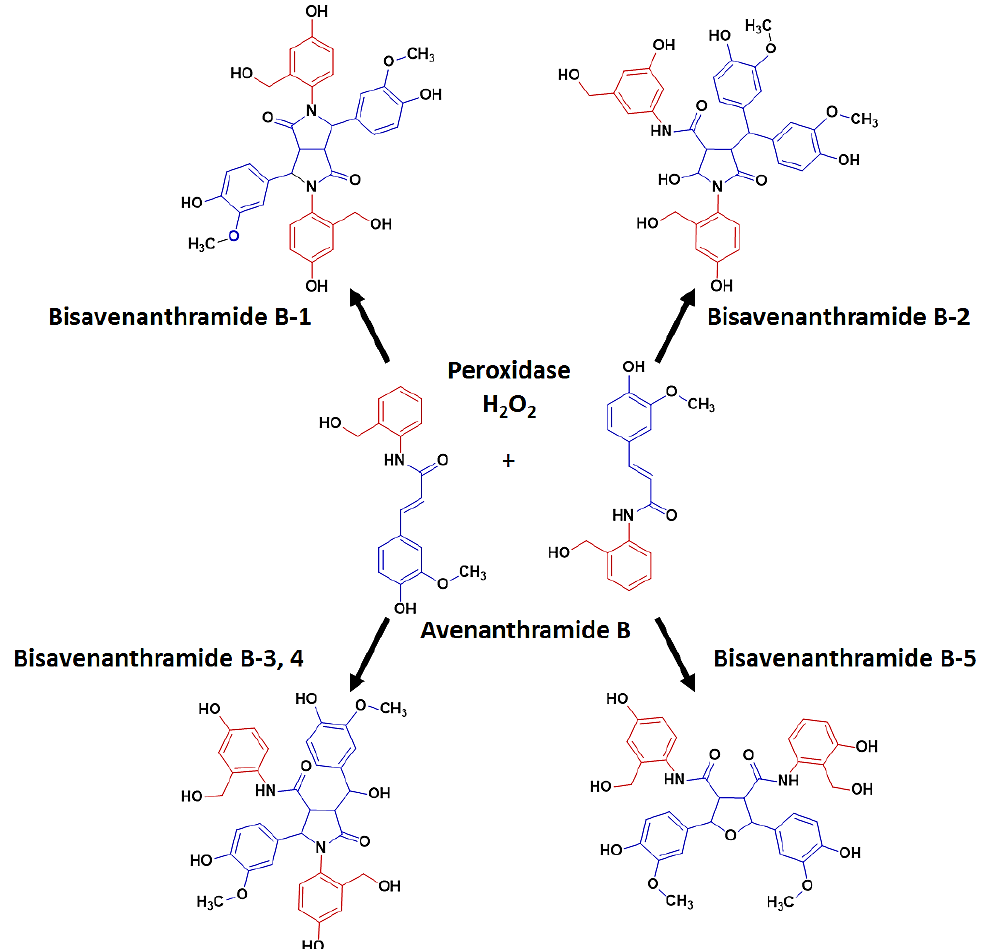
Figure 3. Representation of the proposed synthesis of bisavenanthramides B1 – B5 from avenanthramide B. Avn B units are coupled in the presence of peroxidase and hydrogen peroxide, and triggered by the production of phenoxy radicals. B1 is a dehydrodimer of Avn B, with a bisbutane lactam skeleton, while 2 – 4 are monohydrated dehydrodimers, with butane lactam structures ( B2 – B4 ), or a tetrahydrofuran structure ( B5 ) (adapted from [44]). Ferulic acid and anthranilic acid moieties are indicated in blue and red, respectively.